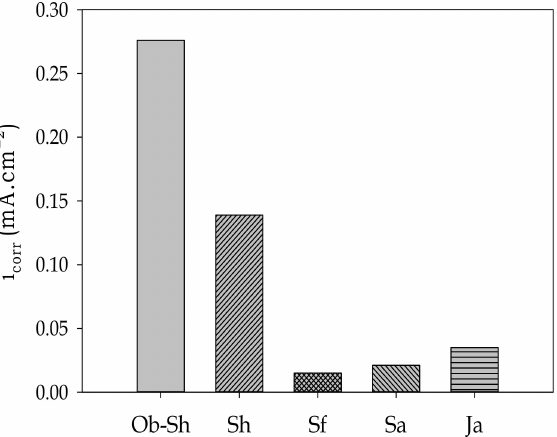
Figure 14. Variation in the value of i corr with the studied Jeddah soil